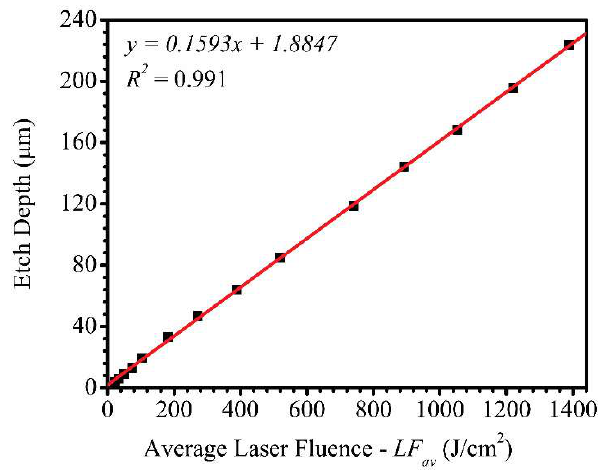
Figure 4. A plot showing the linear dependence of etch depth on average laser fluence (LF av ) while keeping all processing parameters constant, such as PS CNC at 0.25 mm / s. Legend—experimental data points: black squares, data fitting: red trace.